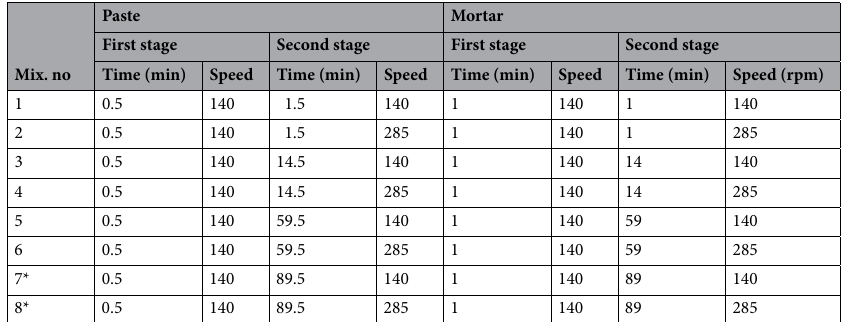
Table 2. Mixing condition for cement pastes and mortars. * for some tests.